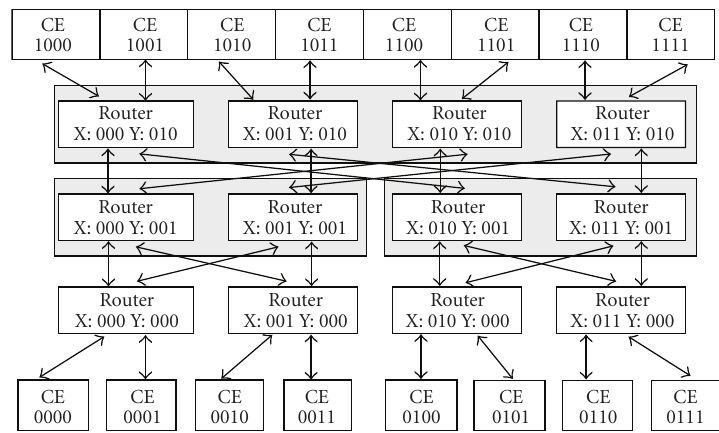
Figure 8: Generic addressing of the CEs and routers depending on their hierarchical levels and their locations into these levels.